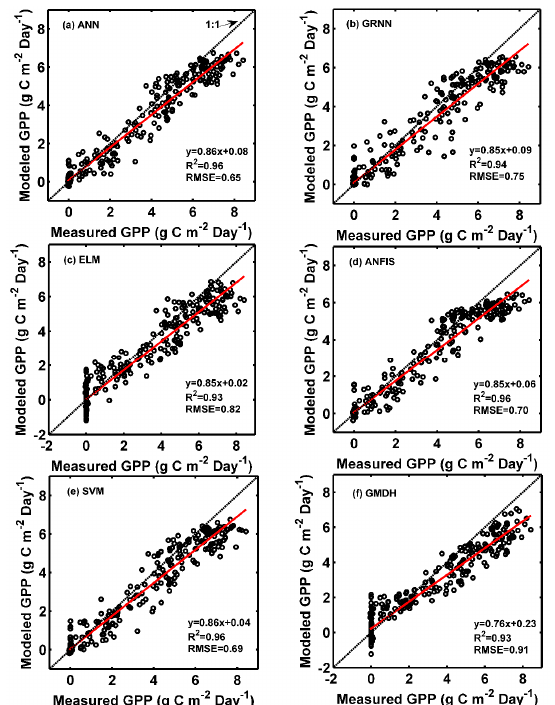
Figure 2. Comparisons of daily GPP measured by eddy covariance technique and predicted by data-driven models for the testing period. ( a ) ANN model; ( b ) GRNN model; ( c ) ELM model; ( d ) ANFIS model; ( e ) SVM model; and ( f ) GMDH model.